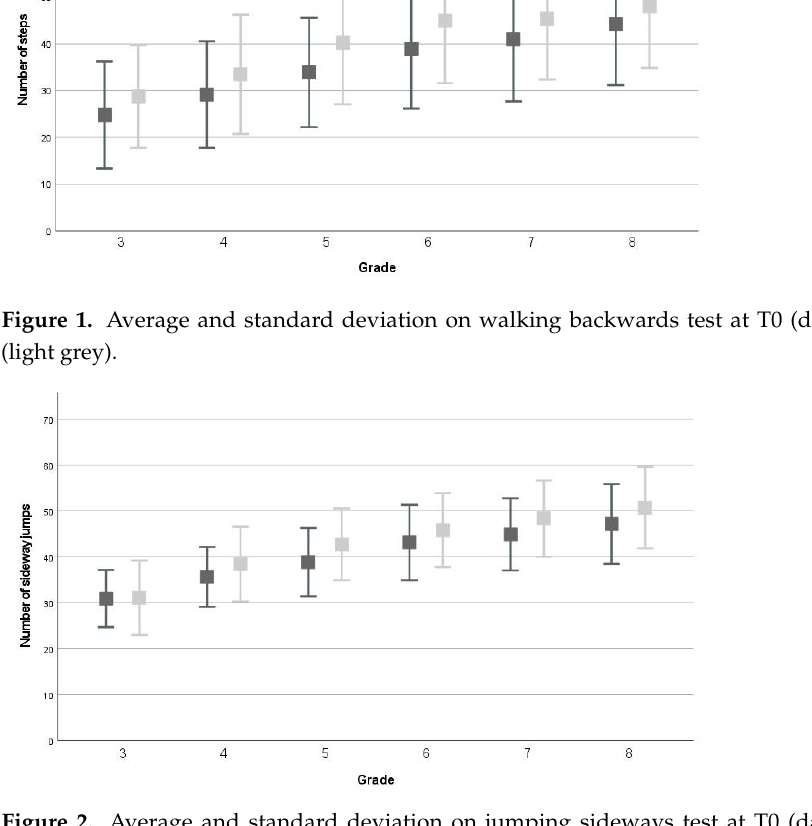
Figure 3. Average and standard deviation on moving sideways test at T0 (dark grey) and T1 (light grey).